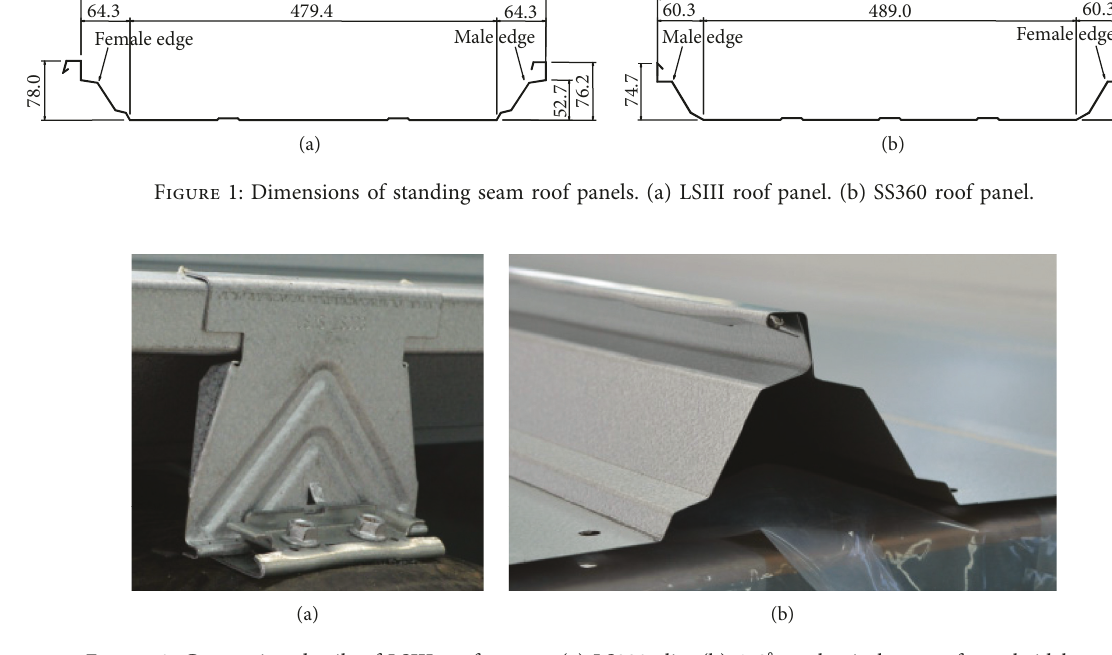
Figure 2: Connection details of LSIII roof system. (a) LS003 clip. (b) 450 ° mechanical seam of panel sidelaps.